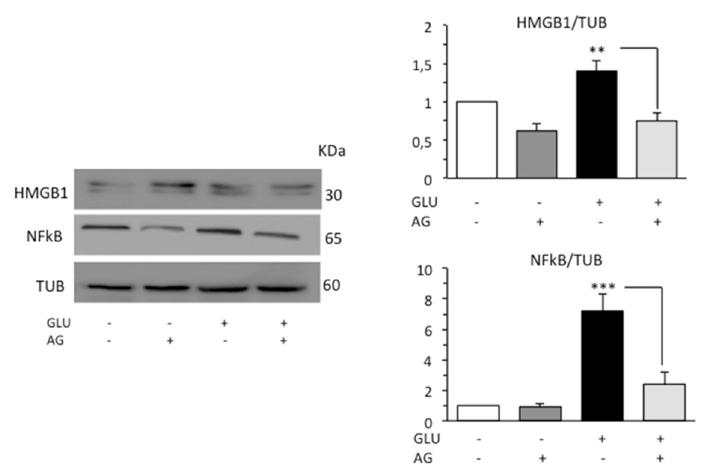
Figure 5. Western blot analysis of the inflammatory proteins HMGB1 and NF κ B. Loading control was evaluated using anti-TUB. A representative experiment among the three is shown. Bar graphs on the right panels show densitometric analysis of the band density ratio of each protein relative to loading control. Mean ± SD from three independent experiments is shown. ** p ≤ 0.01 and *** p ≤ 0.001.